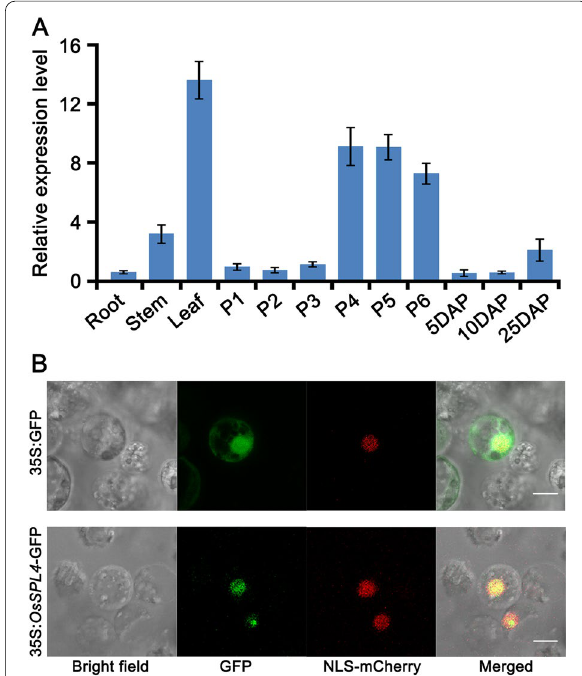
Fig. 7 The expression patterns and subcellular localization of OsSPL4 . A The expression patterns of OsSPL4 in different tissues. P1–P6 indicates a plant with a panicle length of 0, 3, 5, 10, 15 and 22 cm, respectively. DAP, days after pollination. B Subcellular localization of OsSPL4-GFP fusion protein. Scale bar